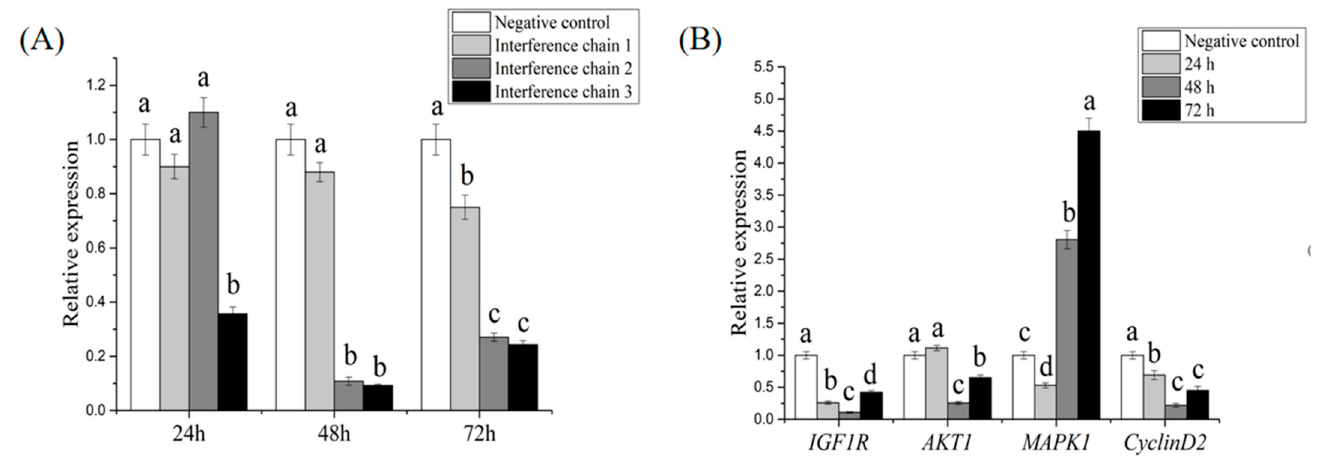
Figure 7. ( A ) Relative expression levels of HcIGF1 in the mantle after interference. Interference chains 1, 2, and 3 represent G1, G2, and G3, respectively. Different letters at the same time point indicate significant differences ( p < 0.05). ( B ) Relative expression of downstream genes of HcIGF1 in the mantle after interference. Different letters for the same gene indicate significant differences ( p < 0.05).